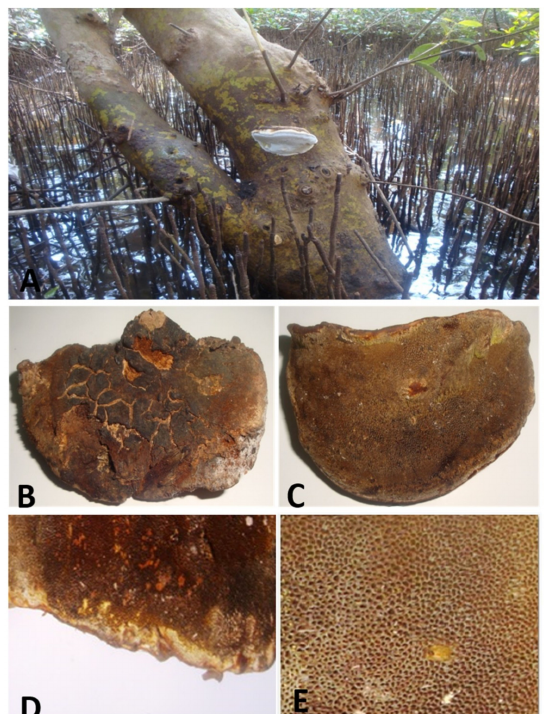
Figure 1. Mushroom collection and their morphological characteristics ( A ) Mushroom Fulvifomes sp. were spotted in A. Marina ( B ) Front view of fruiting body ( C ) Back view of fruiting body ( D ) Tubes ( E )